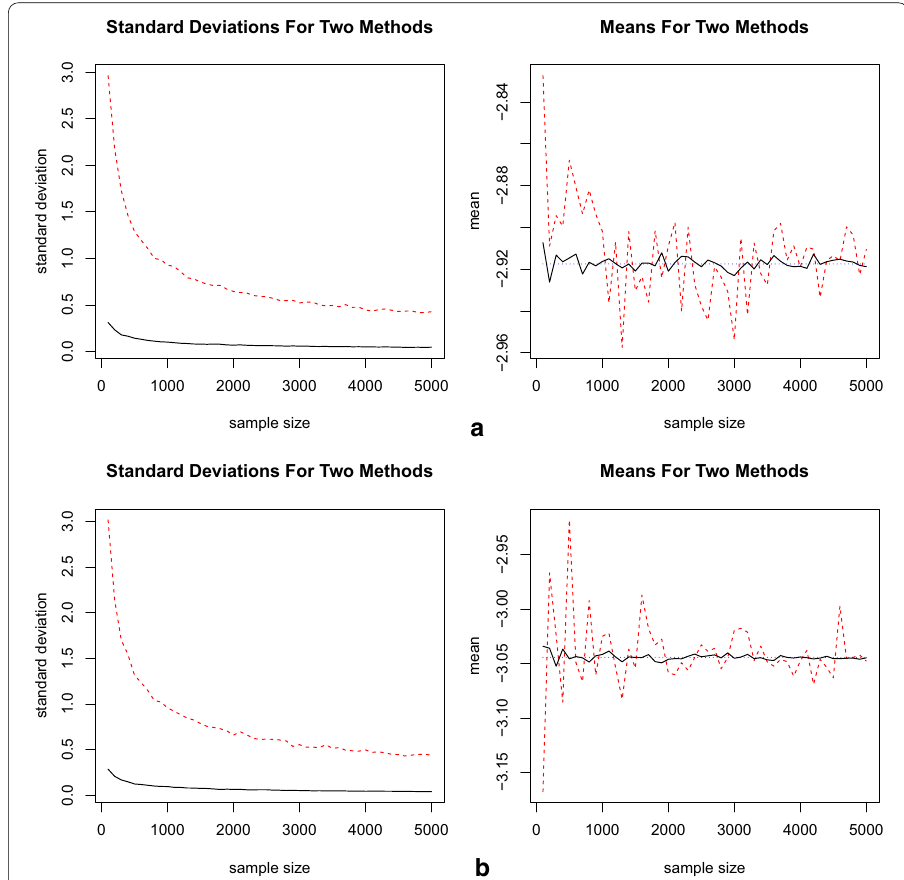
M 1 (τ , σ) are in dashed (red) line and the ones for 0.01 . Results for Fig. 1 Results for τ = (black) line. The dotted (blue) line corresponds to an approximation of N ( 0,1 ) with σ N 2 10 8 . a Results for ǫ 0.3430 . Here, H is evaluated using (9). b Results for ǫ (cid:31) ∼ = = 0.3228 . Here, H is evaluated using with σ =